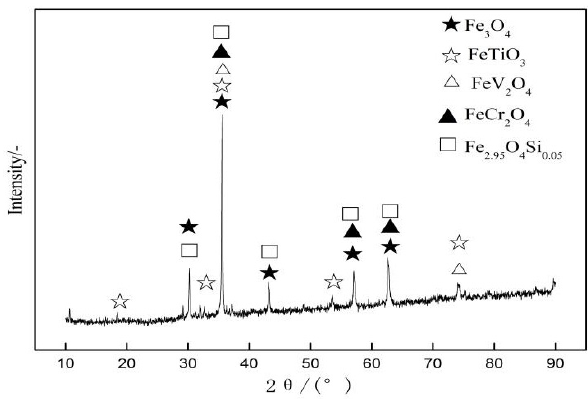
Table 2. Industrial analysis of coke breeze and chemical composition of the ash (mass, %).